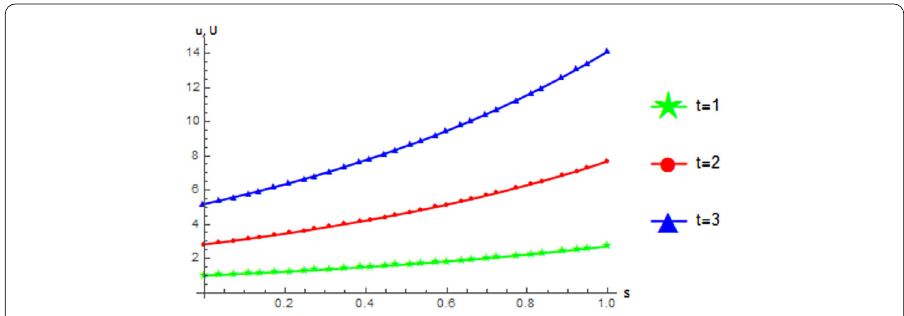
Figure 7 The exact (solid) and approximate solutions (stars, bullets, triangles) for Example 3 when τ = 0.01, h = 1 , and γ = 0.5 at various time 80